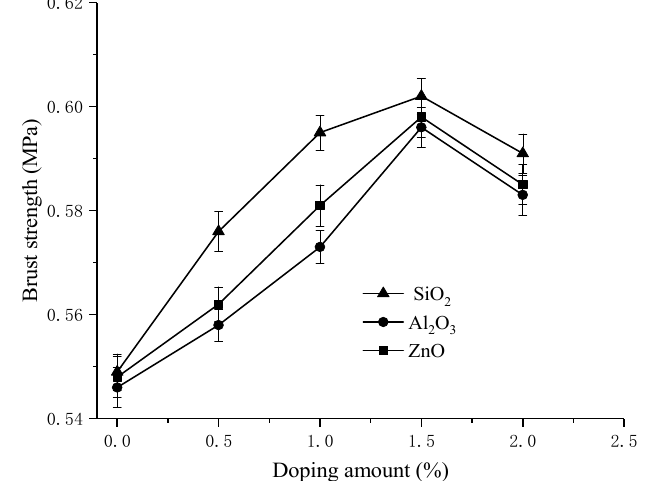
Figure 8. The effect to the burst strength curve of prepared membranes under different doping amounts of nano-SiO 2 , nano-Al 2 O 3 and